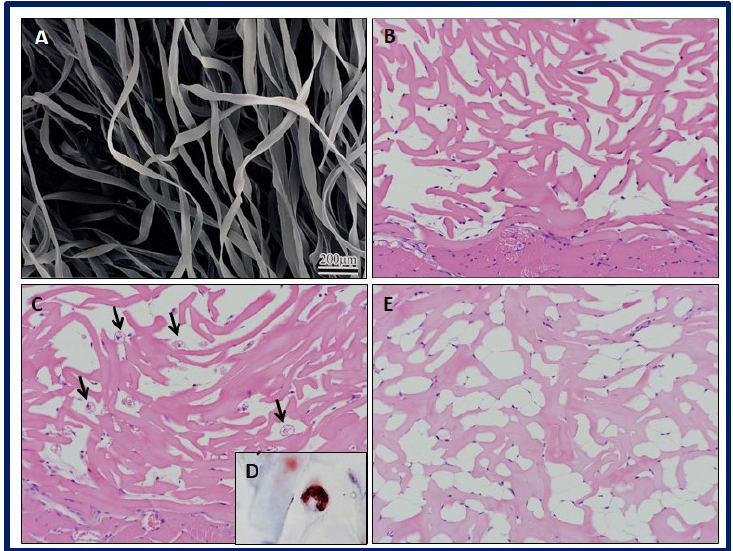
Figure 24. SEM micrograph showing the ( A ) FSA scaffolds. Histological examination of implant specimens of FSA scaffolds at different weeks (Hematoxylin and Eosin staining). ( B ) Week 1: Note the presence of stained spindle cells attached to scaffold fibers. ( C ) Week 2: Black narrows indicate brown-like adipocytes within the scaffold, with multiple cytoplasmic lipid droplets. Note the presence of some small spherical cells close to scaffold fibers. No inflammatory reaction is observed. ( D ) Week 2: Multiple cytoplasmic lipid droplets within the cells are stained with Oil Red O staining. ( E ) Week 4: Multiple white-like adipocytes within scaffold bulk are observed, with large cytoplasmic lipid droplets. Bibliography consulted [196].